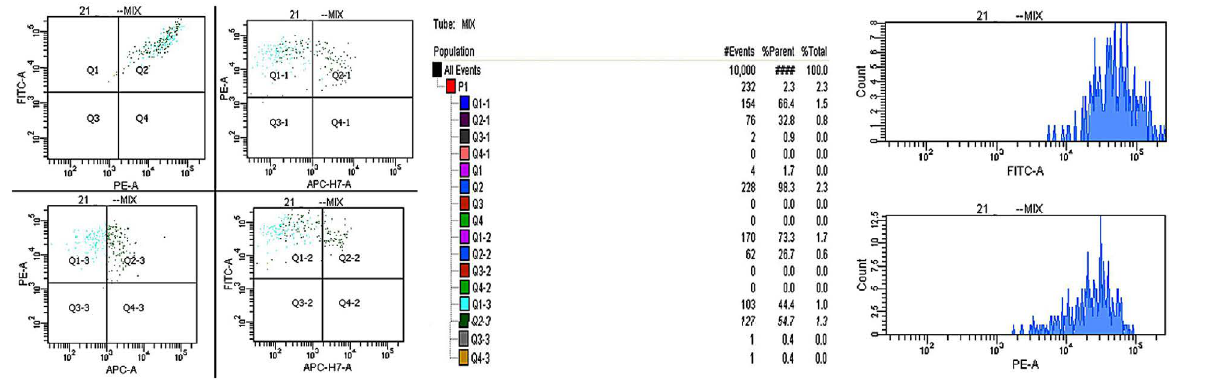
Figure 2. The double-positive areas and expression rates of DPSC after 21 days. Q2: CD73 (PE) + CD90 (FITC).